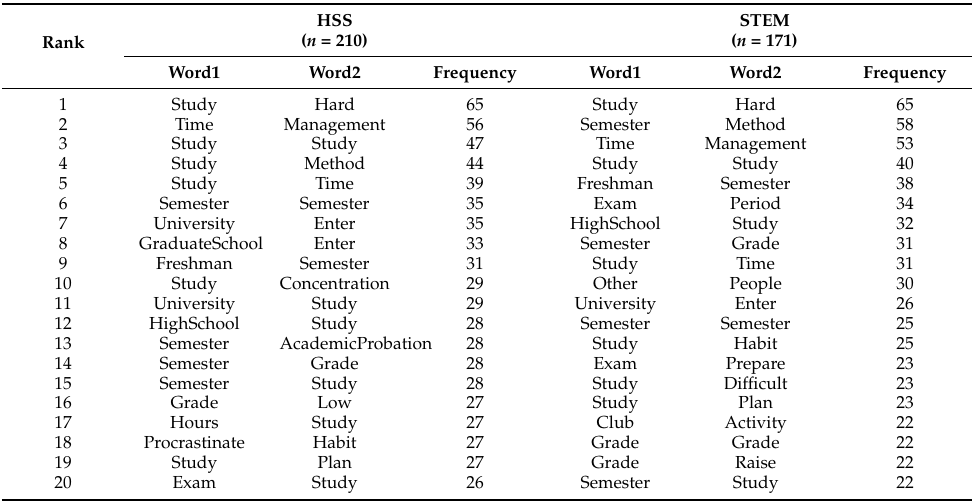
Table 5. Bigram of word relations for HSS and STEM tracks.